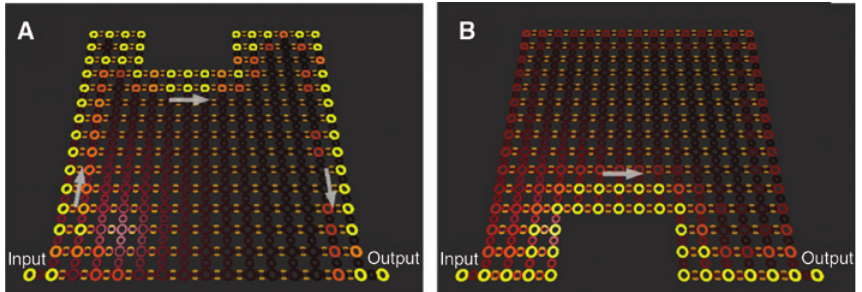
Figure 4: Field distributions inside 15 × 15 resonator array for topologically protected states with lattice perturbations (defects) at working wavelength λ = 1.305 μ m. (A) Topologically protected state (1) number (50 mW applied power). Direction of propagation is indicated by